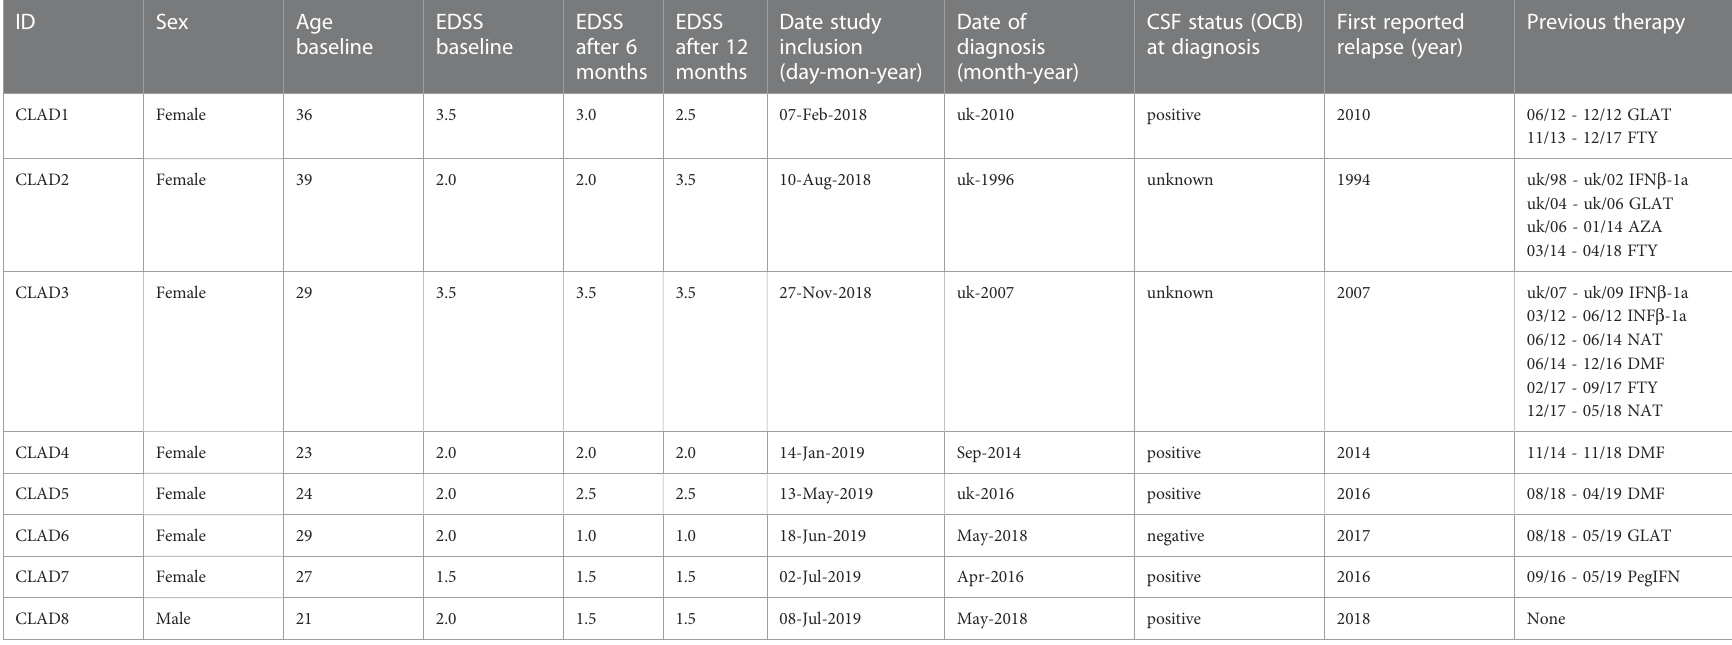
TABLE 1 Patients